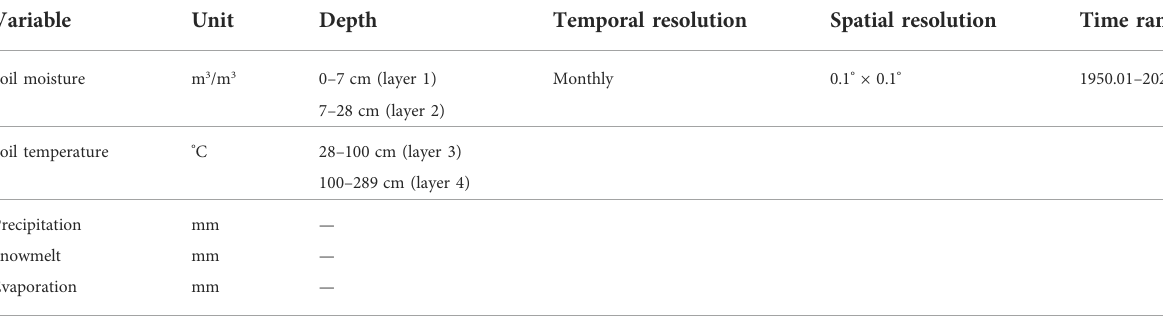
TABLE 1 Basic properties of the employed soil moisture and ancillary climatic variable datasets.